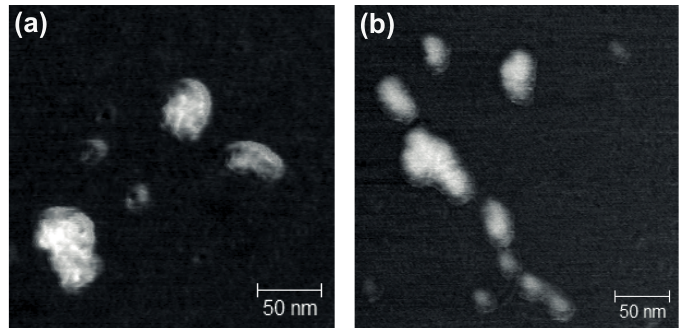
Figure 6. Atomic force microscopy images of the dendriplexes of carbosilane dendrimer ( a ) BDEF32 and ( b ) BDEF33 with siRNA Bcl-2. The charge ratio is 5.